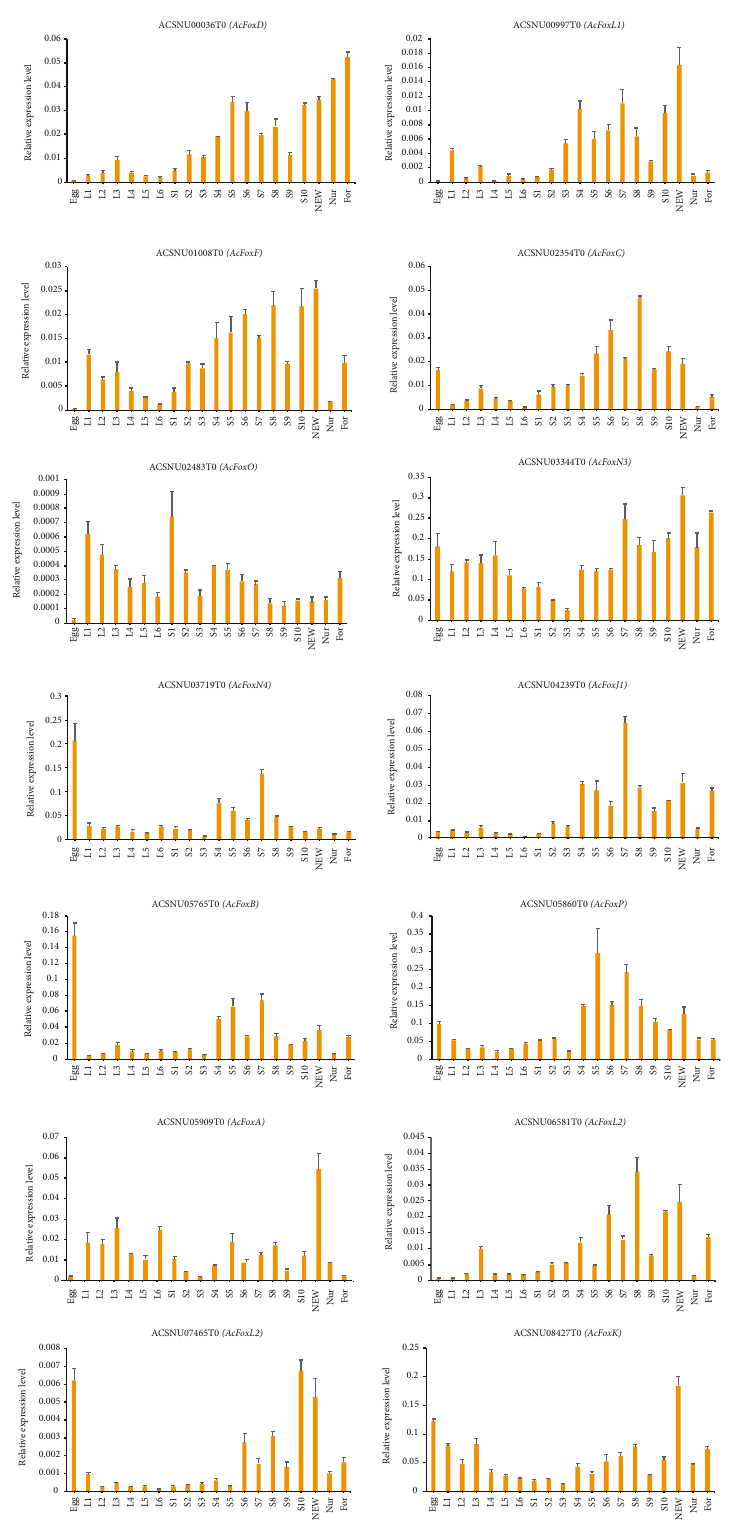
Figure 5: Analysis of the temporal expression pattern of 14 Fox genes in A. cerana . Egg: mix eggs from day 1 to 3; L1 – L6: day of larval stage, from day 1 to day 6; S1 – S10: day of pupal stage after cell sealing, from day 1 to day 10; NEW: newly emerged workers; Nur: nurses; For: